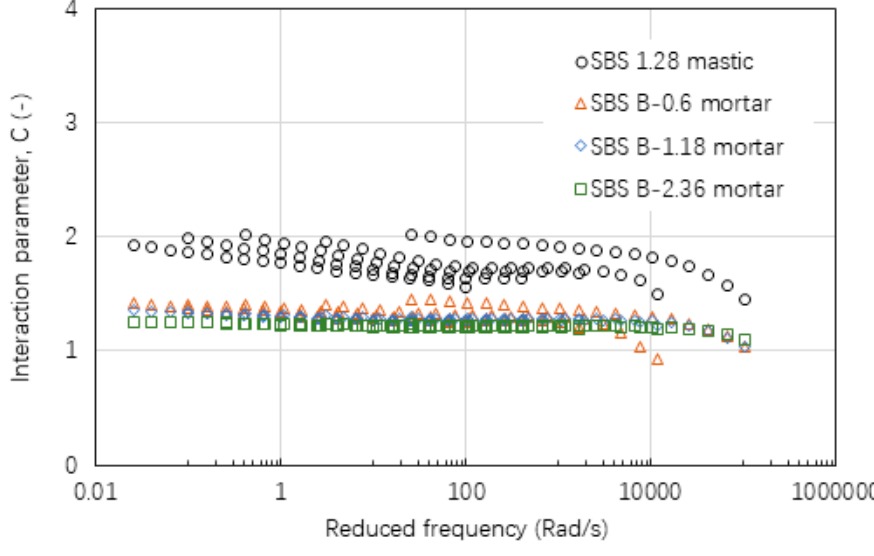
Figure 17. Interaction parameter of C values for asphalt mastic and mortar based on AC-13 mixture. Table 6. A summary of interaction parameter, C values of various asphalt materials.